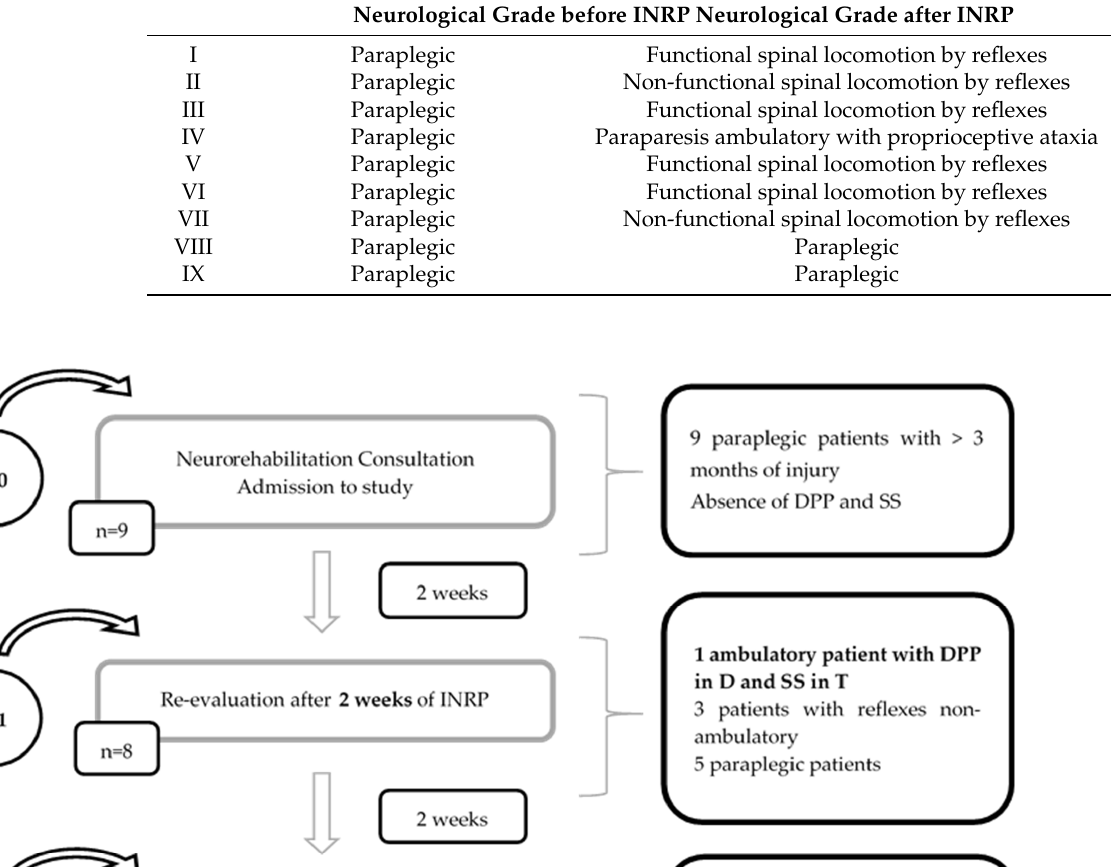
Table 3. Ambulation capacity at the end of the study.